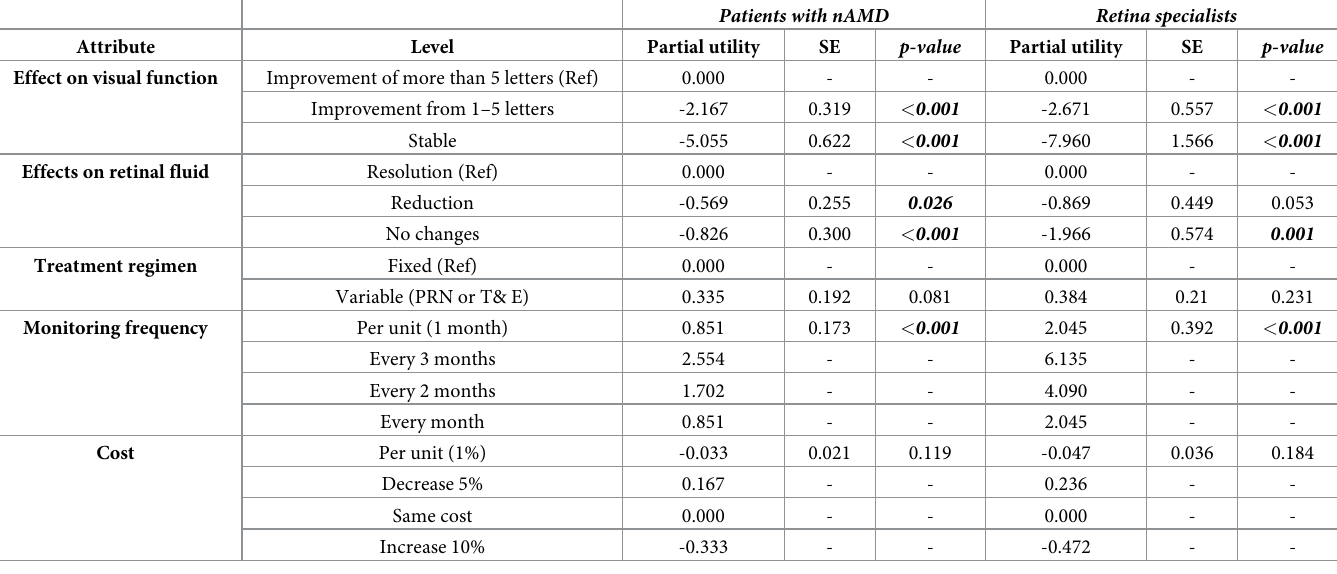
Table 2. Patient and retina specialists’ partial utilities.